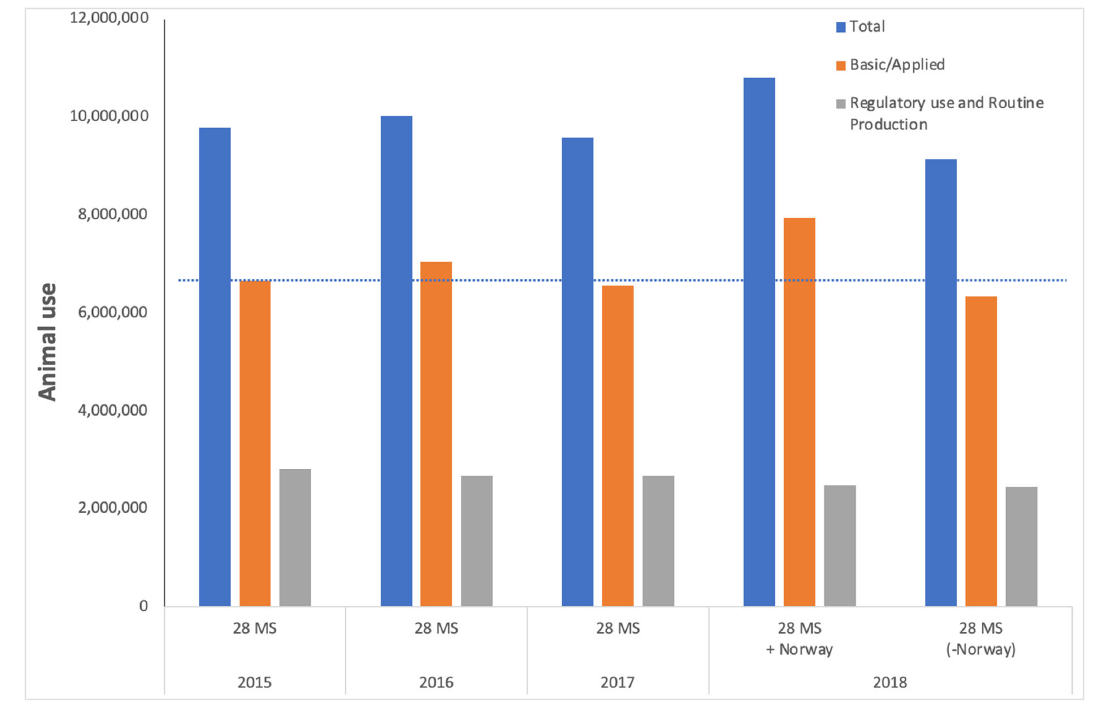
Figure 1. Animal use across the European Union is not undergoing any sustained decline. The blue bars indicate total animal use recorded for each year for all purposes, and according to the counting requirements defined in Directive 2012/63/EU and recorded in ALURES. The orange bars are combined animal use for Basic research and Translational and applied research and the grey bars represent the number of uses of animals for Regulatory use. Note that data from Norway are included in the ALURES database for the first time in 2018, creating an artificial increase in animal use. This is addressed with the data presented as the bars on the far right, which are from the 28 Member States (in direct comparison with the data from 2015, 2016, and 2017). The dotted line indicates the level of use for basic research and translational and applied research in 2015 and tracking this across to the bars on the far right illustrates the absence of any significant decrease in animal use for these purposes.